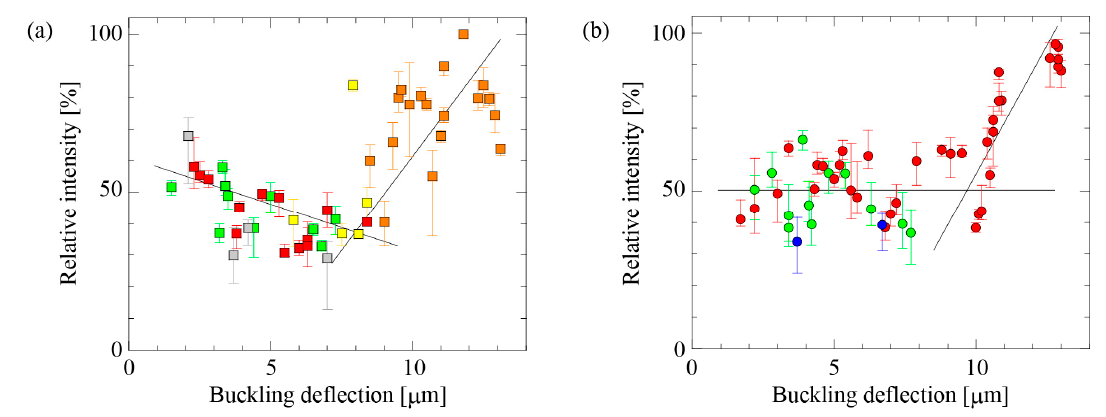
Figure 5. Relative intensity of the dominant vibration mode versus buckling deflection: ( a ) square diaphragms, and ( b ) circular diaphragms. Error bars indicate maximum and minimum values and plot marker indicates average value in 10-time